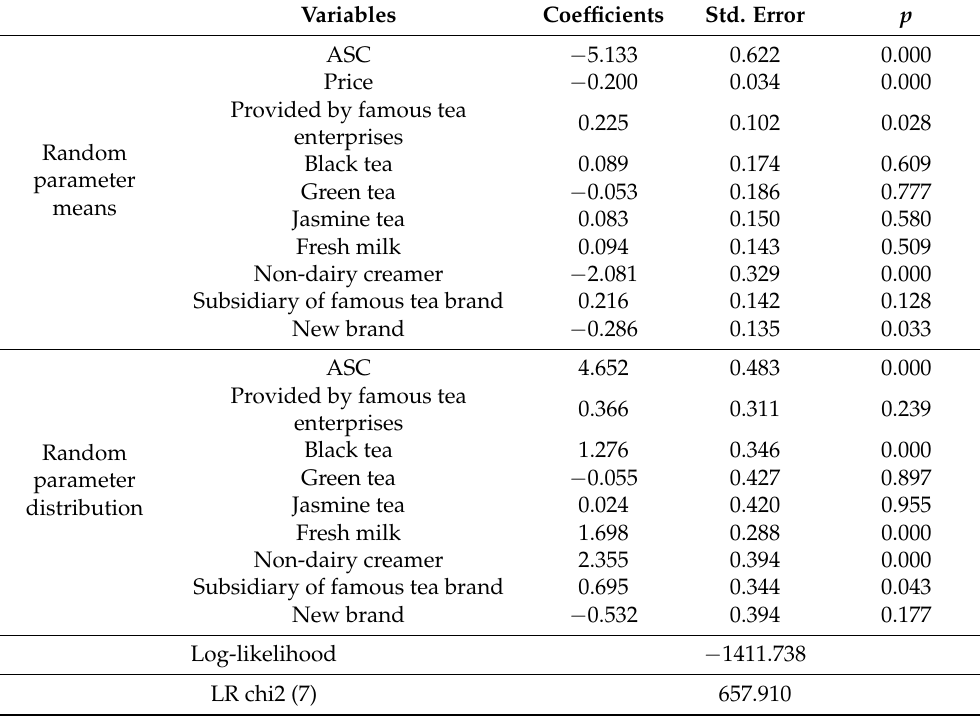
Table 3. Estimation of the main effects of attributes using the RPL